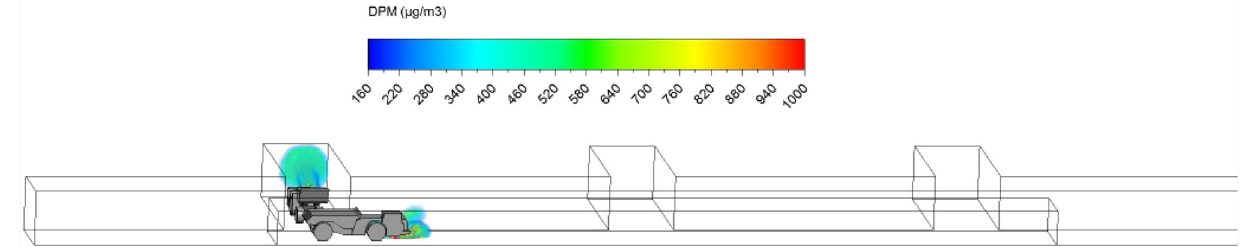
Fig. 14 DPM distributions in scenario 2 during the loading operation at 3 s